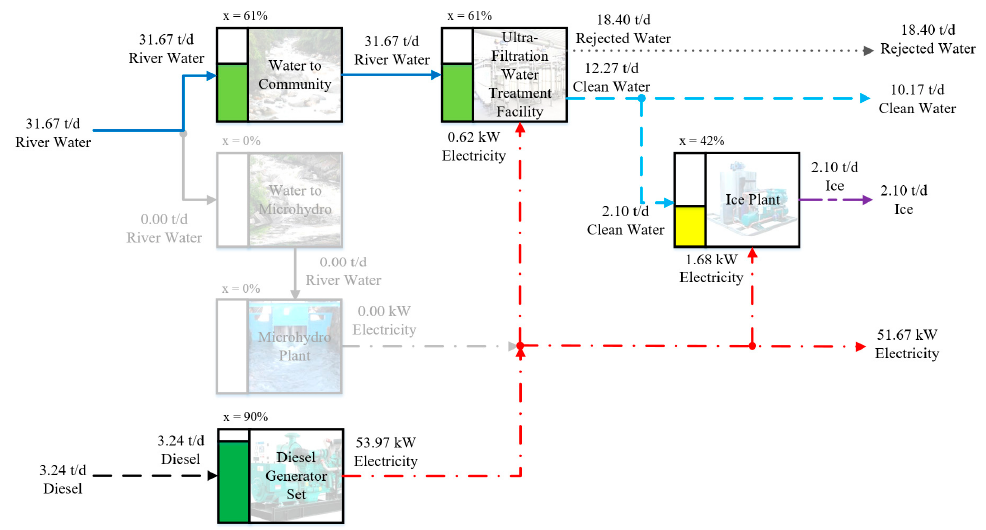
Figure 7. The optimal configuration of the polygeneration system of case study 2 under D = 0.90 (or 90%).